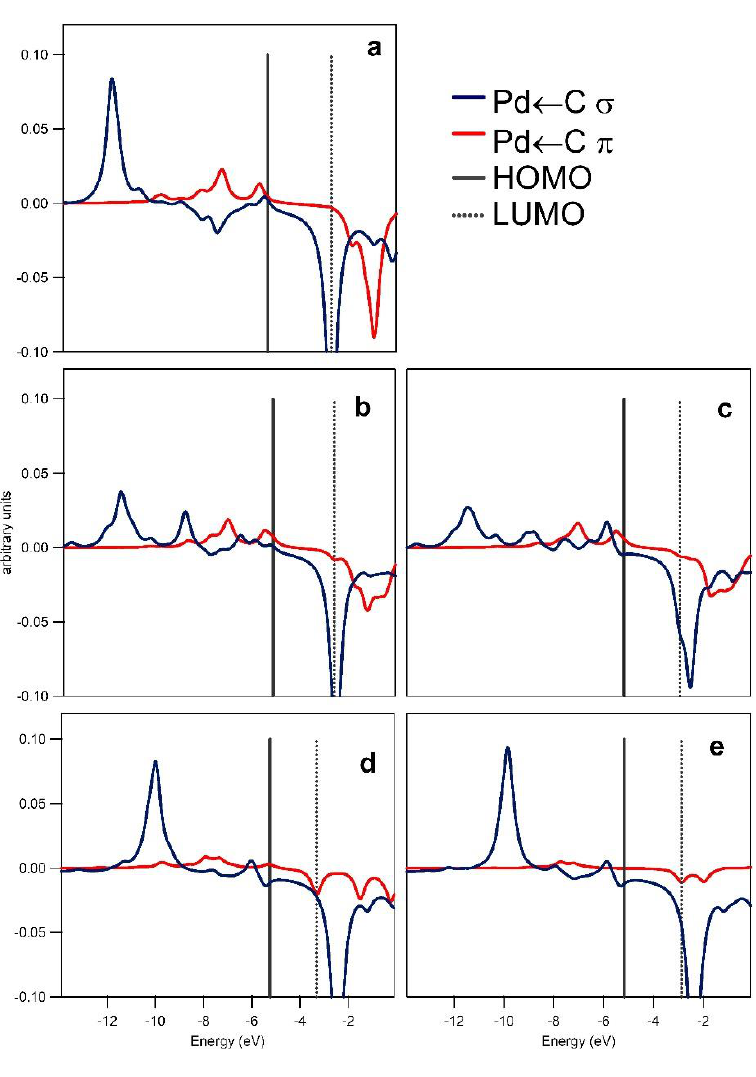
Figure 3. Crystal orbital overlap populations (COOPs) for the Pd–C interaction in 1 ( a ), TS6 ( b ), TS14 ( c ), Z - P2 ( d ), and Z - P1 ( e ). Bonding/antibonding interactions correspond to the positive/negative peaks, respectively. Solid and dotted vertical lines correspond to the highest occupied molecular orbital (HOMO) and the lowest unoccupied molecular orbital (LUMO), respectively.